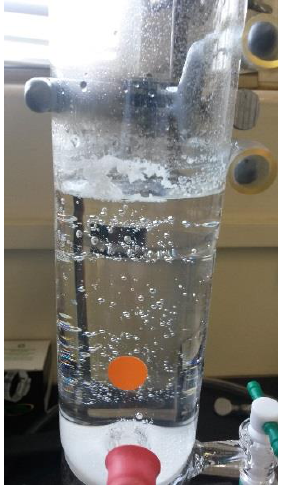
Figure 3. Scum concentrating on the solution surface and adsorbing to the column while floating La 3+ at φ = 2.